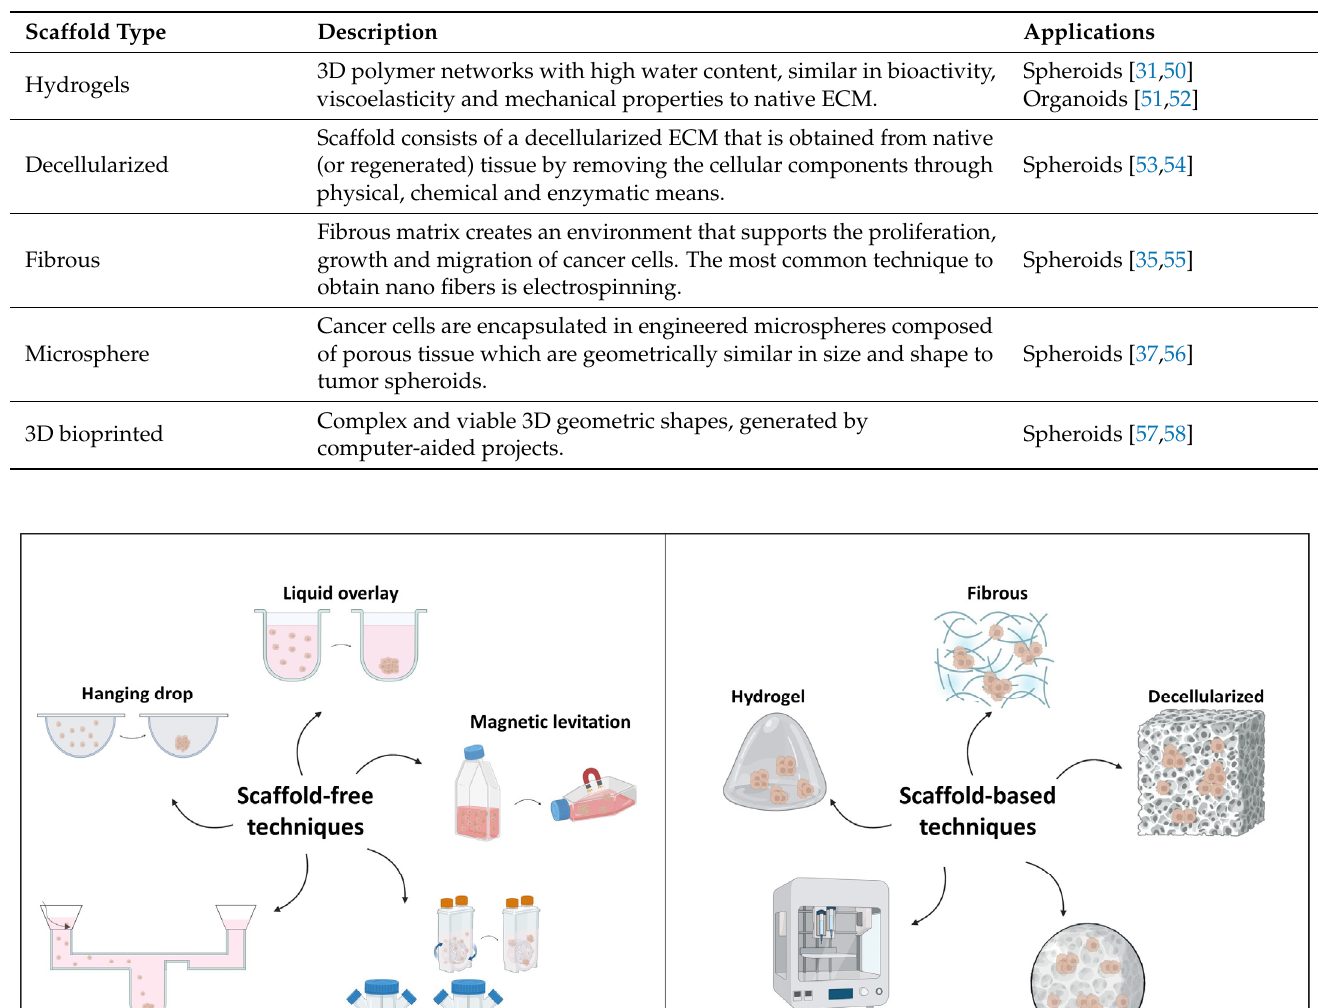
Table 2. Scaffold-based techniques. Table 2. Sca ff old-based techniques.